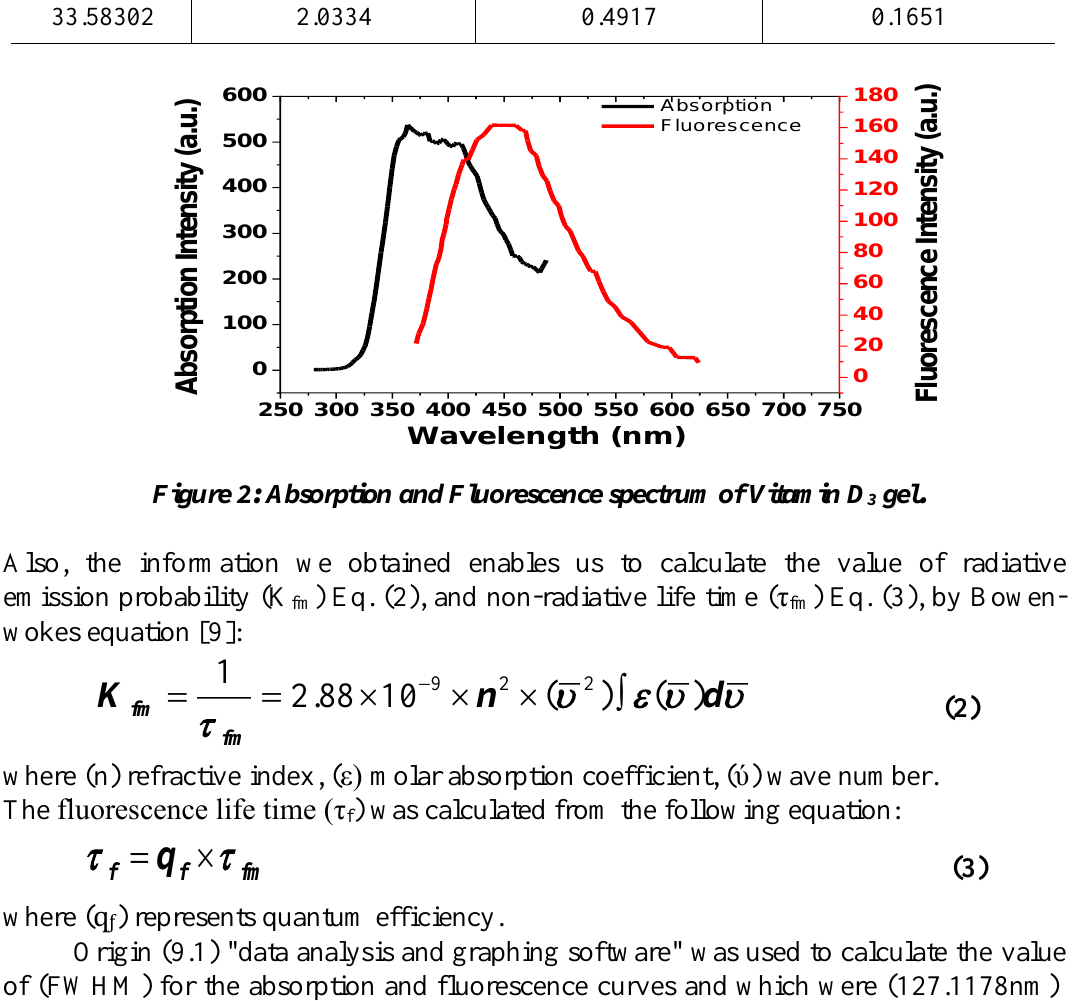
Table 2: Quantum efficiency; non-radiative and fluorescence life time of Vitamin D